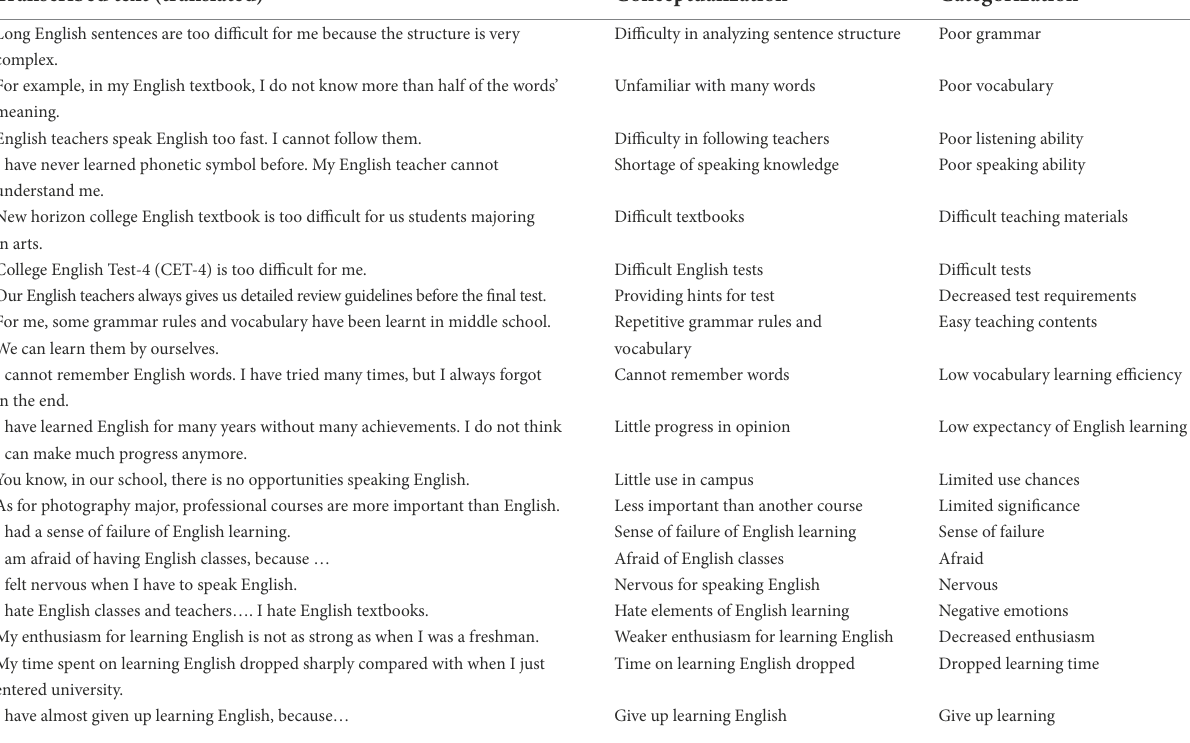
TABLE 3 Open coding